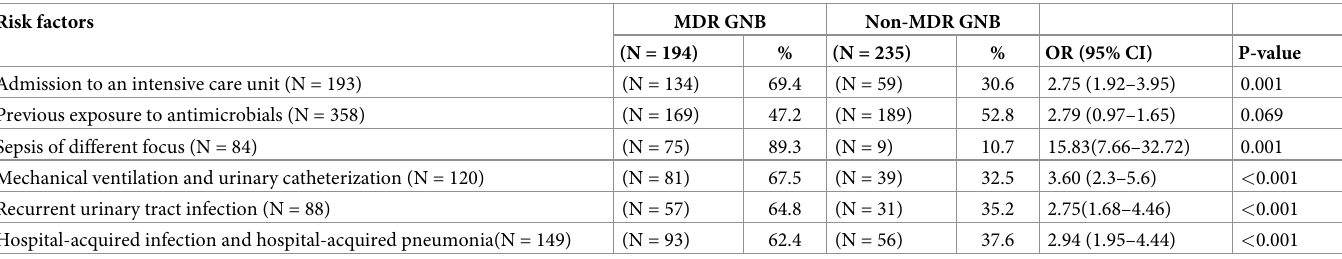
Table 3. Univariate analysis of MDR GNB